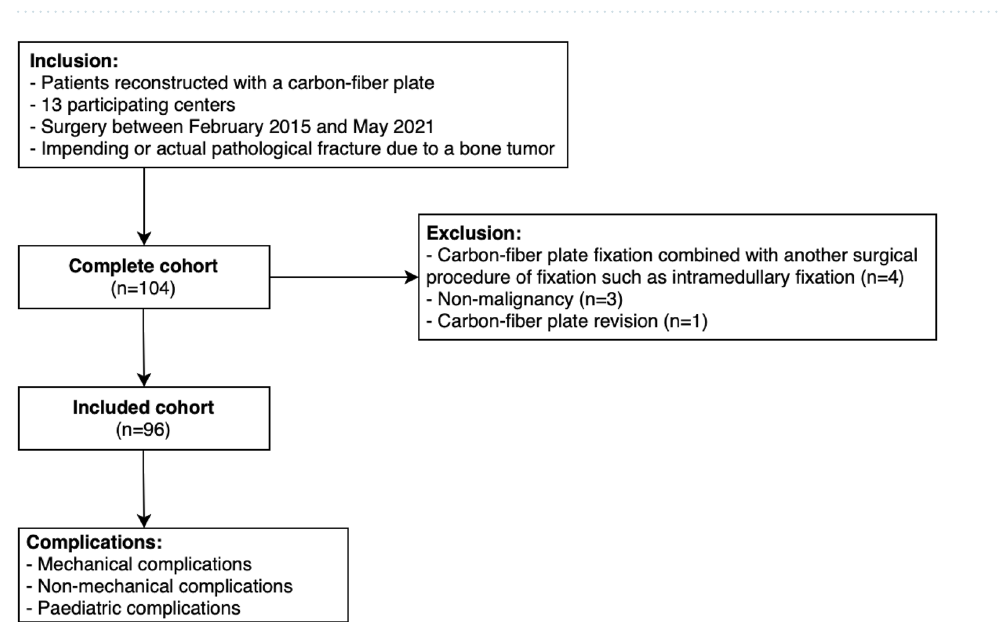
Figure 2. World map showing all 13 participating centers.